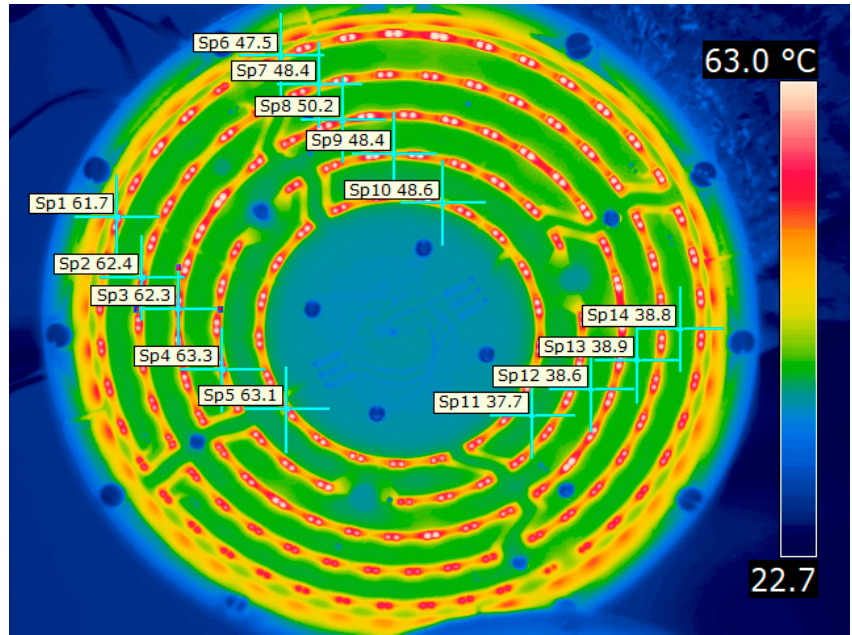
Figure 8. The thermal image of the PCB with LEDs for P LS = 4.50